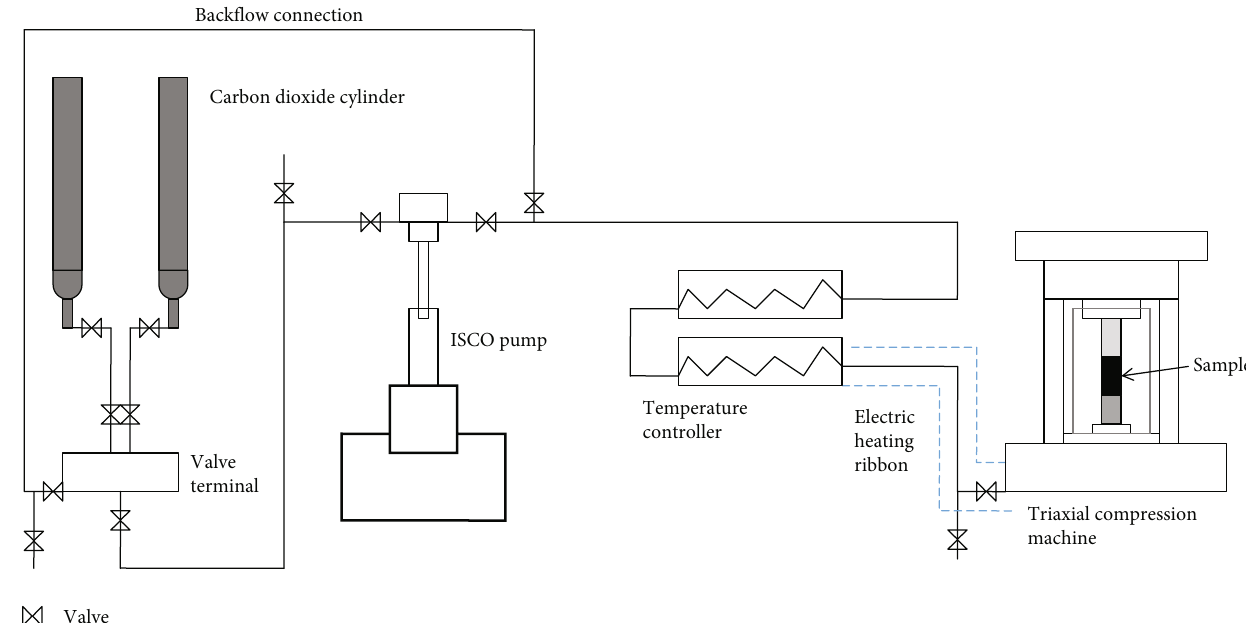
Figure 3: Schematic of SC-CO